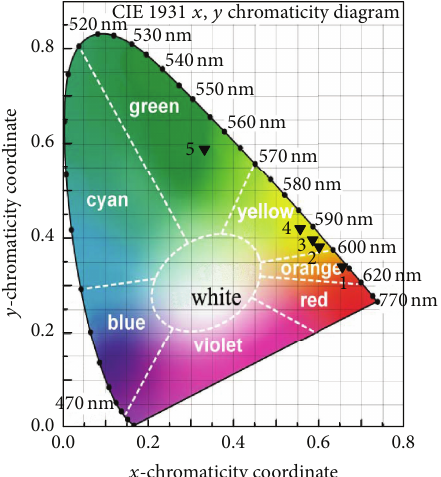
Figure 4: CIE ( 𝑥,𝑦 ) chromaticity diagram indicating the color coordinates of the fluorescence in samples, and the coordinates cor- responding to points from 1 to 5 are in 0.2 wt% EBA, 0.4 wt% TBA- 0.2 wt% EBA, 0.8wt% TBA-0.2 wt% EBA, 1.4 wt% TBA-0.2wt% EBA, and 0.2 wt% TBA incorporated